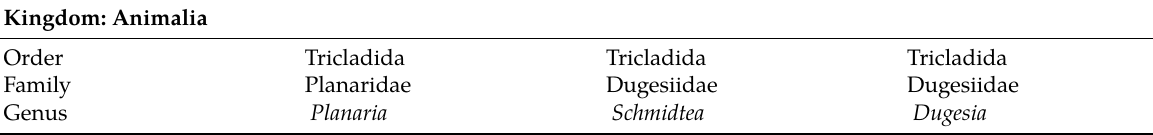
Table 1: Systematic position of Planaria sp., Schmidtea sp., Dugesia sp. Kingdom: Animalia